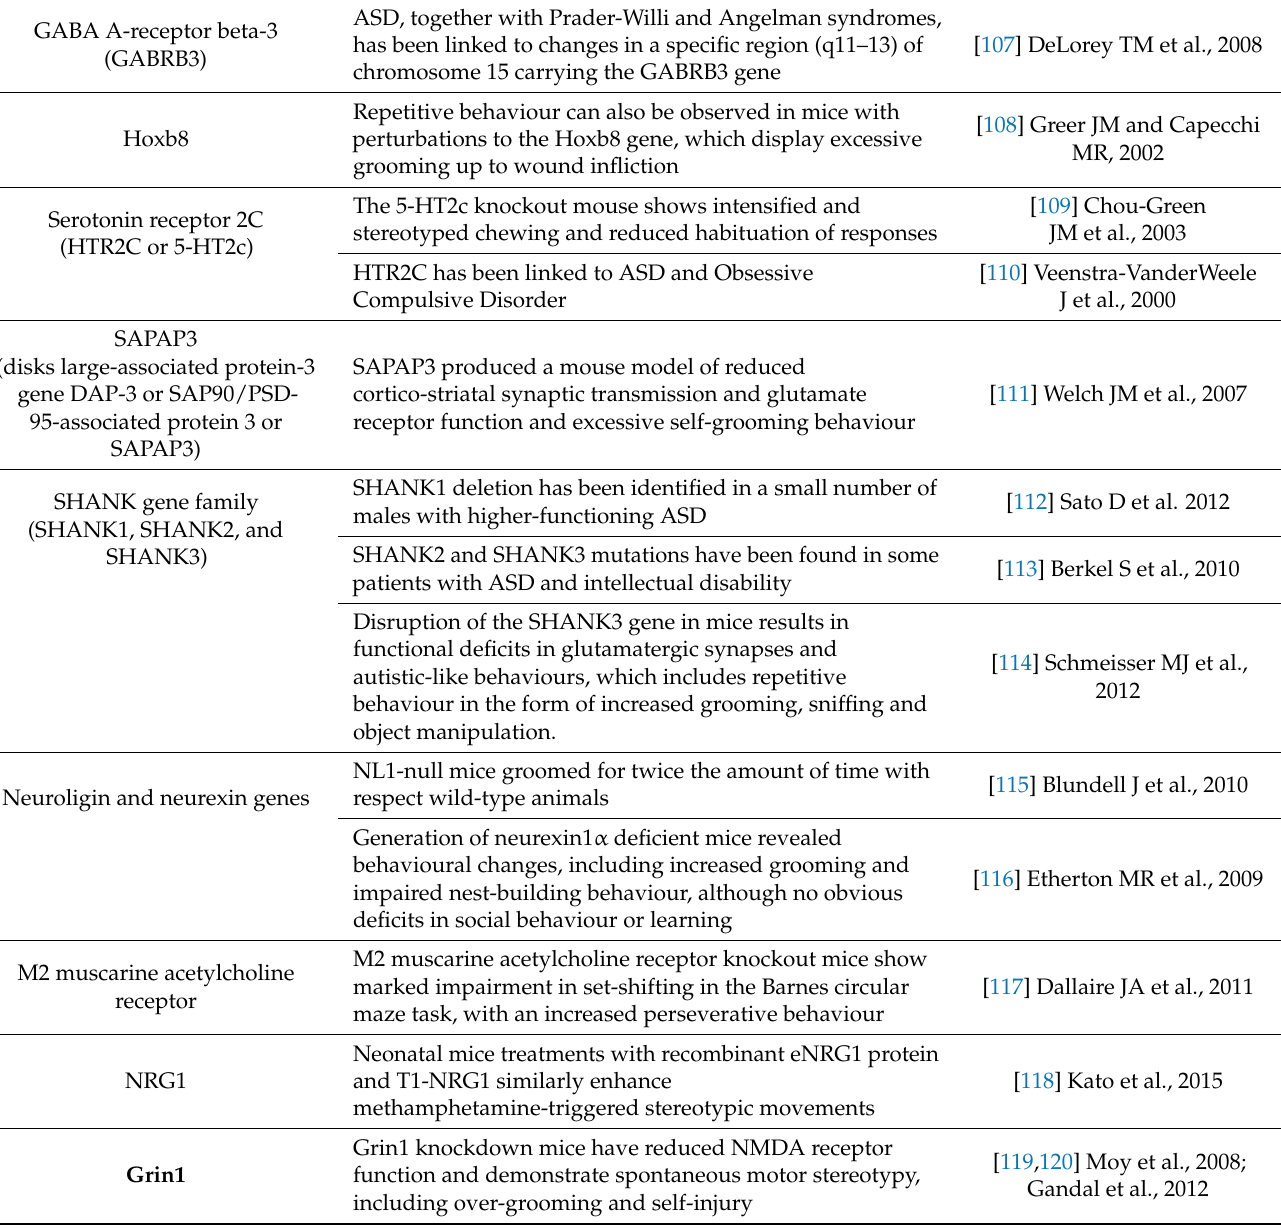
Table 2. Genes that may potentially affect abnormal repetitive behaviour.